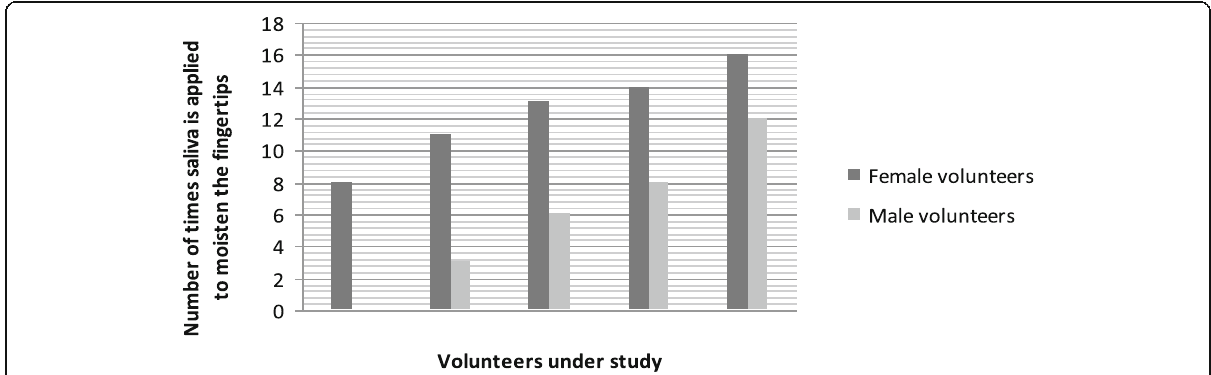
Fig. 2 Female dominance in applying saliva on document over